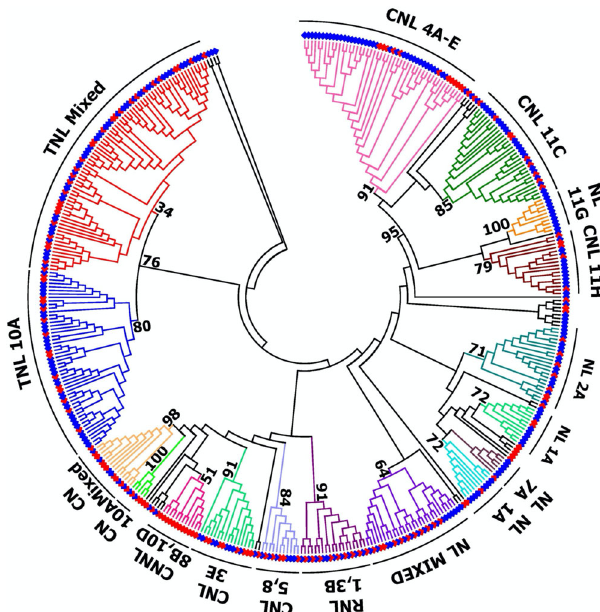
Fig. 3 Phylogeny of the Phaseolus acutifolius Frijol Bayo and Phaseolus vulgaris G19833 NB-ARC gene families. Neighbor-joining tree of the NB-ARC containing gene models from the two species. Cluster designations (outer ring) are as described in Supplementary Data 8 and 9. Red diamonds represent P. acutifolius gene models, and blue diamonds represent P. vulgaris gene models. Bootstrap values (out of 100 replications) are shown for major